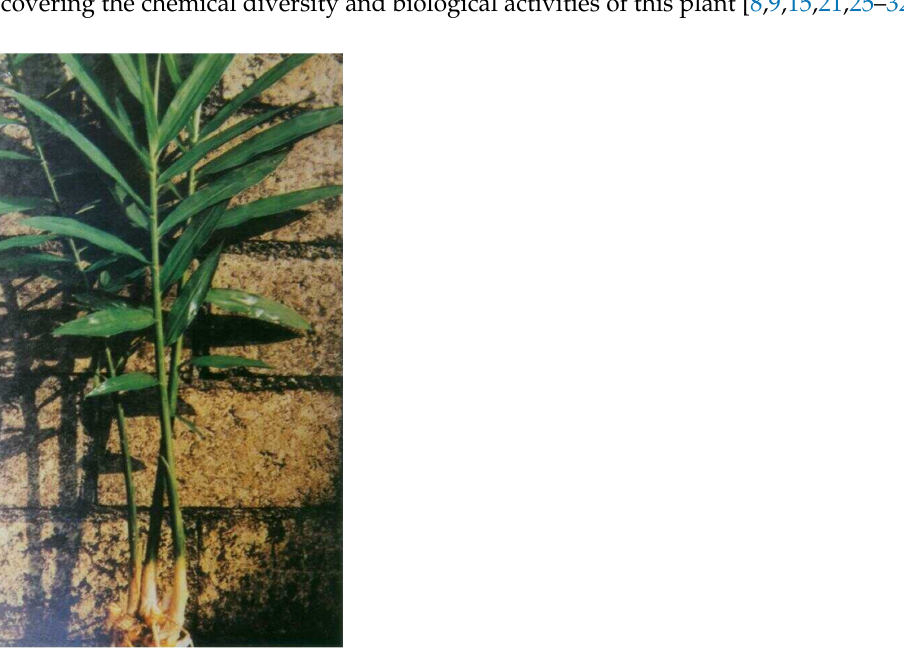
Figure 1. Photograph of a sample of Z. cassumunar collected from Surabaya, Indonesia, in 2001, which was identified by Professor Tri Windono (University of Surabaya,